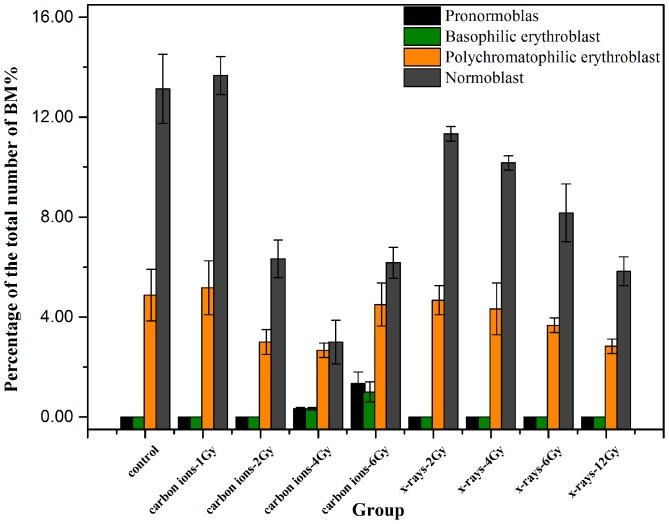
The number of erythroid cells in BM accounted for the relative percentage of the total of BM cells after exposed carbon ion beams or X-rays.From the column chart showed that the pronormoblast and basophilic erythroblast seemed upward tendency with the increasing of absorbed dose in carbon ions radiation, but the change in X-rays radiation groups seemed to be not obvious, as for the polychromatophilic erythroblast and normoblast, the percentage of cells number had decreased significantly in two types of irradiation, and the differences between groups had significant statistical significance (p<0.05).